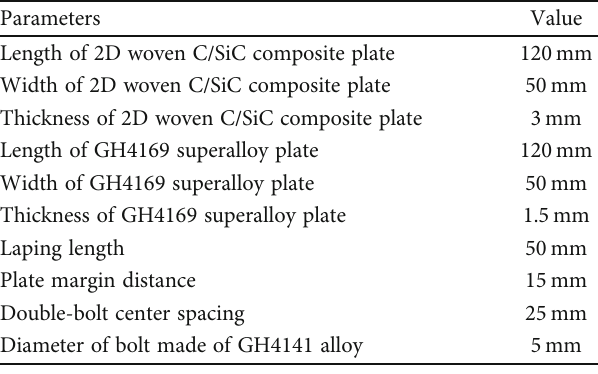
Table 1: Material types and structural parameters of the studied C/ SiC composite and superalloy double bolted joint.